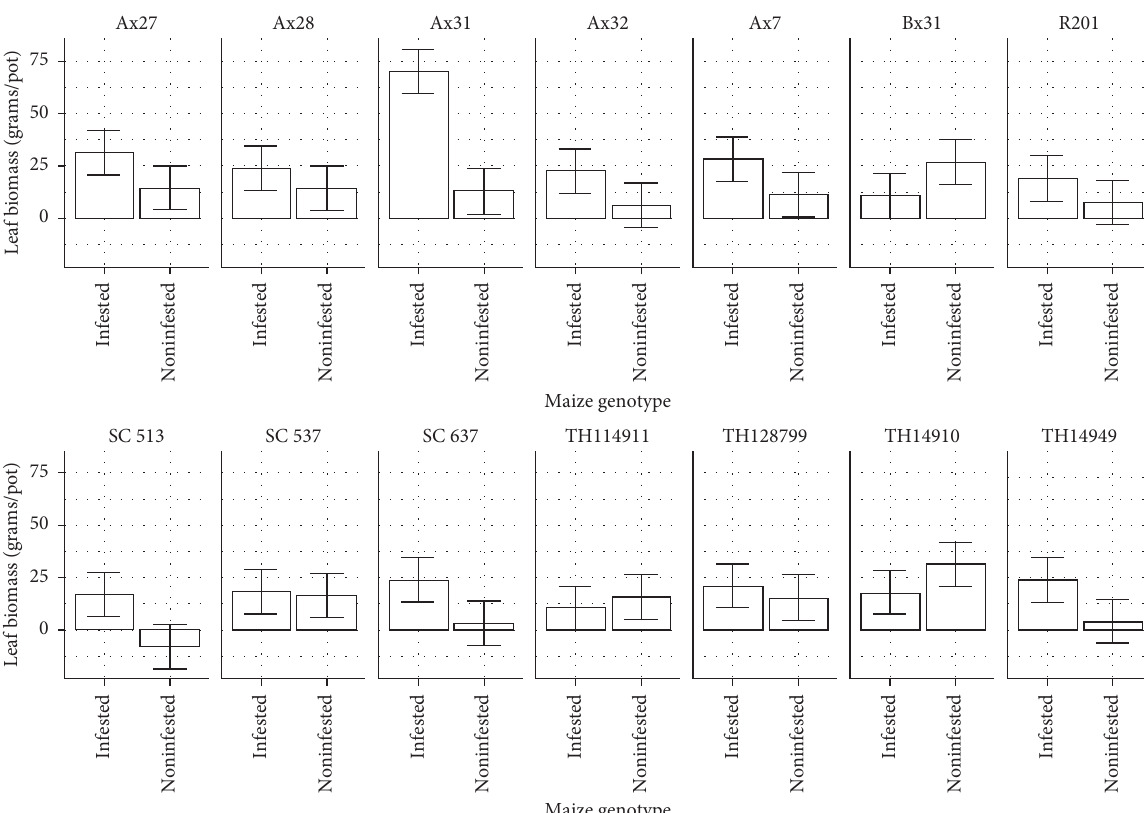
Figure 2: Comparison of individual genotypes’ leaf biomass across the two Striga levels in pot experiment. Error bars indicate the standard errors of the difference between